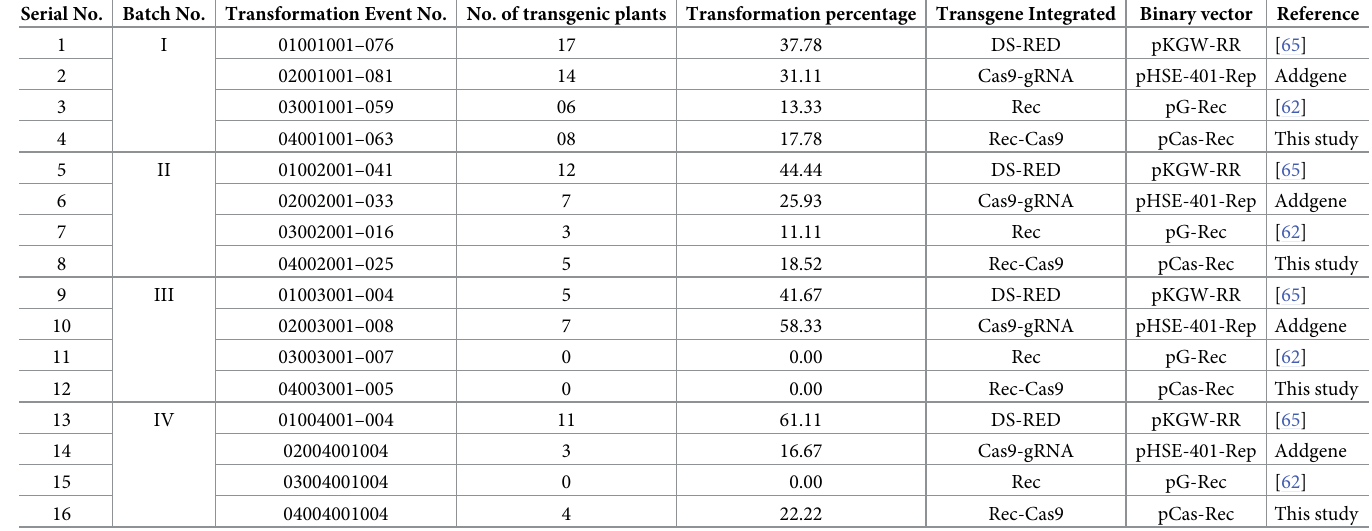
Table 2. Transformation events. Number of independent transformation events, regenerated embryos, positively transformed plantlets and transformation percentage per batch measured for four plasmids (1, 2, 3 and 4 for pKGW-RR, pG-Rec, pHSE-401–Rep and pCas-Rec respectively).